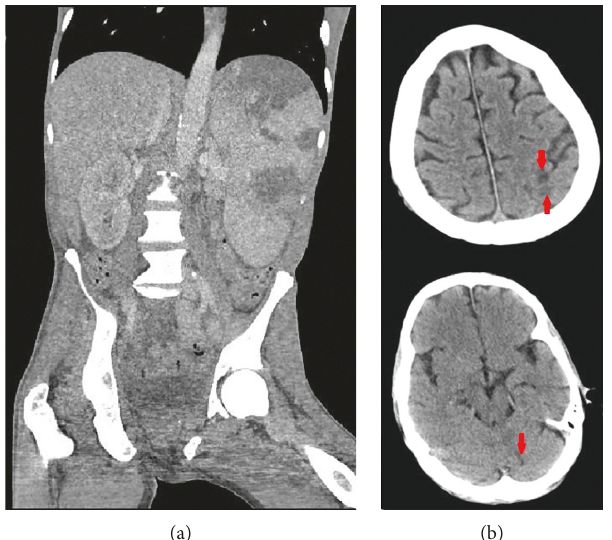
Figure 1: (a) Computed Tomography (CT) of the abdomen and the pelvis without contrast showing large wedge-shaped splenic infarcts. (b) CTof head without contrast displaying hypodensities in the left parietal lobe and left cerebellum due to septic emboli, shown in red